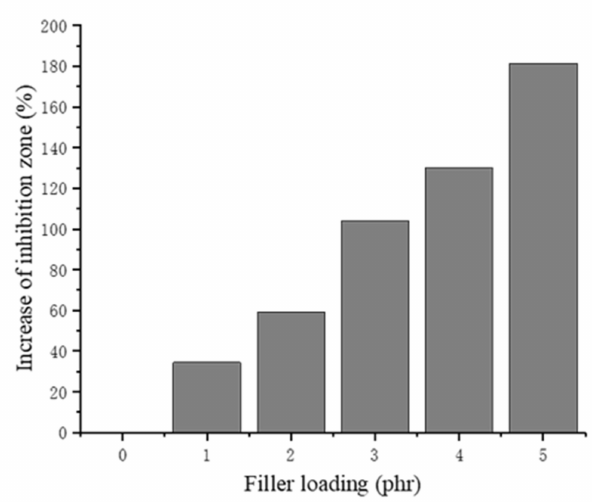
Figure 12. Increase in the inhibition zone of